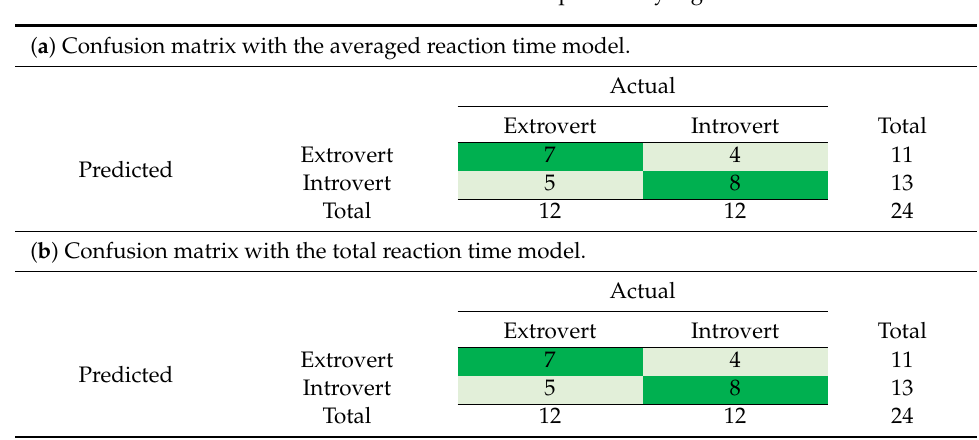
Table 5. Validation results of the developed binary logistic